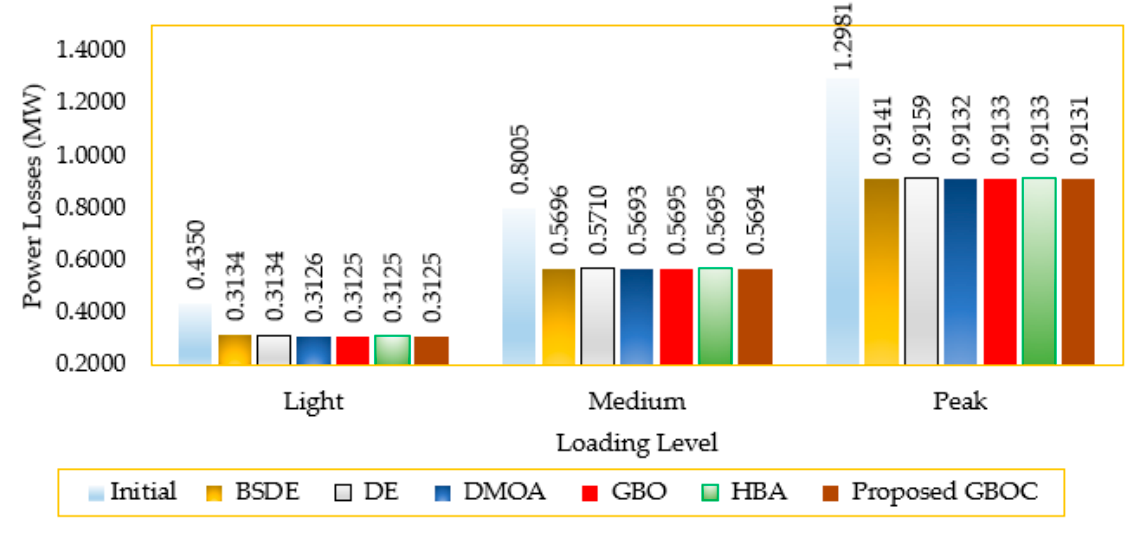
Figure 22. Power losses (MW) in each loading level based on the obtained D-SVC devices in Table 8 compared to the initial case.